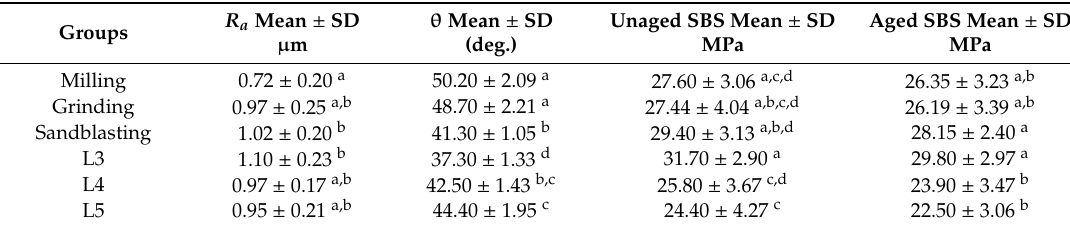
Table 7. Summarized results of surface roughness R a , contact angle θ measurement, and shear bond strength (SBS) values of studied